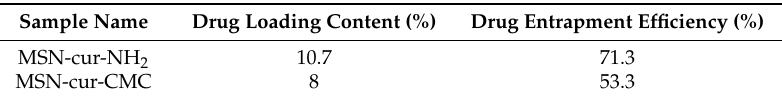
Table 3. Curcumin loading in functionalized MSNs.